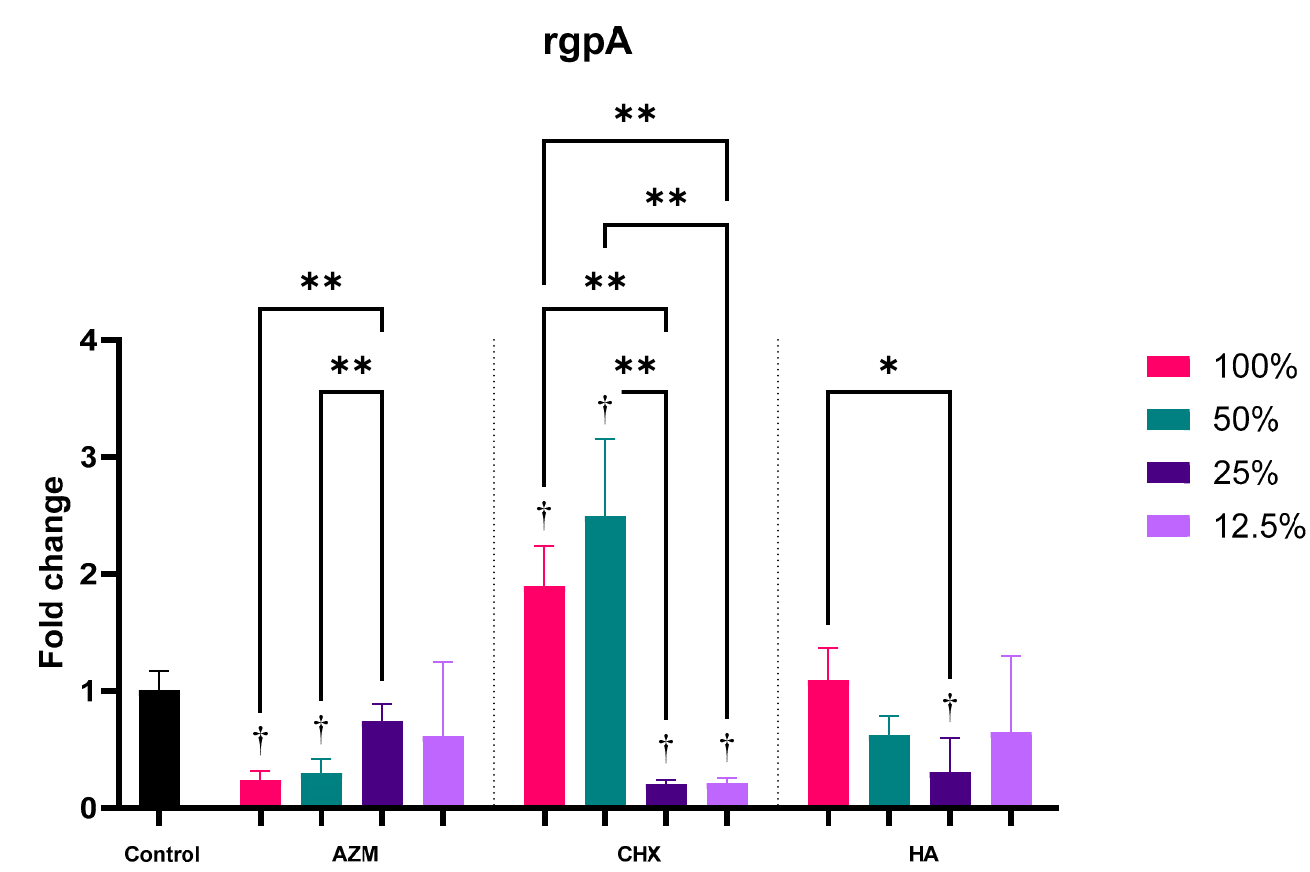
Figure 7. Fold-change values (mean ± SD) of different concentrations on expression of rgpA. >0.05 (ns), ≤ 0.05 (*), ≤ 0.01 (**), ≤ 0.001 (***), ≤ 0.0001 (****). Statistically significant compared to control p < 0.05 (†).